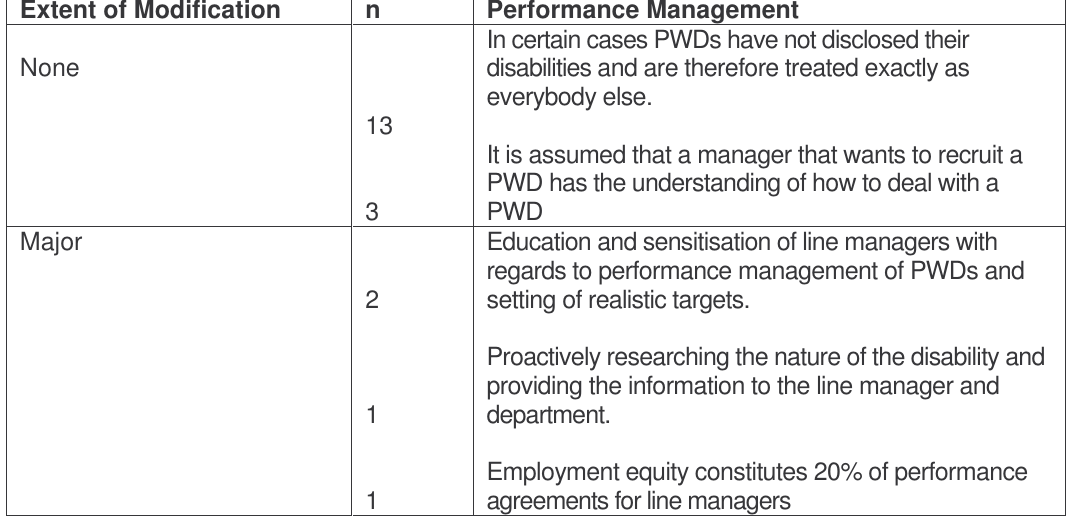
Table 7: Performance management Extent of